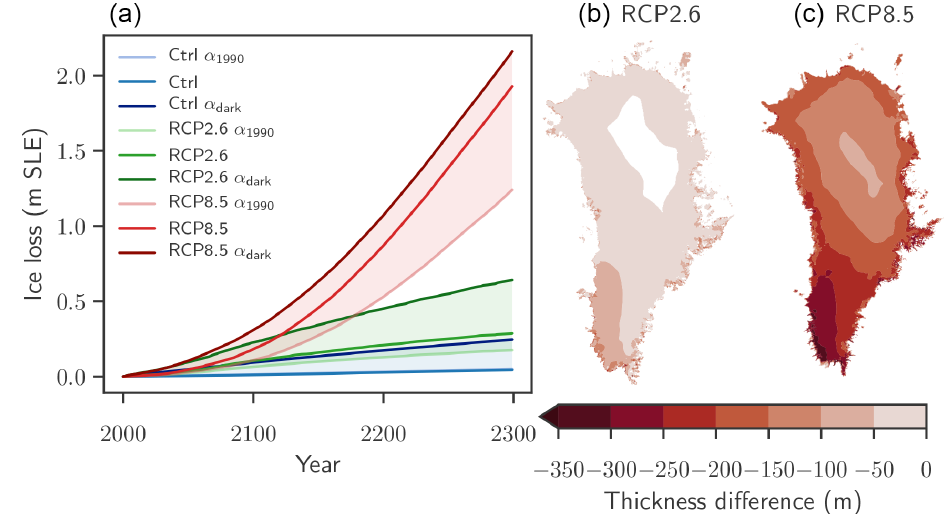
Figure 5. Influence of the melt–albedo feedback on Greenland’s ice loss under future warming. The scenarios consist of a control experiment (blue) and temperature forcing with RCP2.6 (green) and RCP8.5 (red). (a) Ctrl, RCP2.6, and RCP8.5: ice losses between 2000 and 2300 modelled with PISM-dEBM-simple using the standard parameters and the respective temperature forcing. α 1990 : ice losses for the respective temperature forcing with monthly albedo fixed to the average pre-1990 values, thereby interrupting the melt–albedo feedback. α dark : ice losses with the respective temperature forcing with summer albedos (June, July, August) set to the bare-ice value over the whole ice sheet. This yields an upper limit of ice loss driven by albedo changes. The shading is to illustrate the range between the lower and upper limits. Ice loss is given in metres of sea level equivalent. A value of 1ms.l.e. corresponds to approx. 361800Gt of ice. Panels (b) and (c) show the ice thickness difference between the lower bound experiments α 1990 and the standard experiments for RCP2.6 (b) and RCP8.5 (c) in the year 2300.